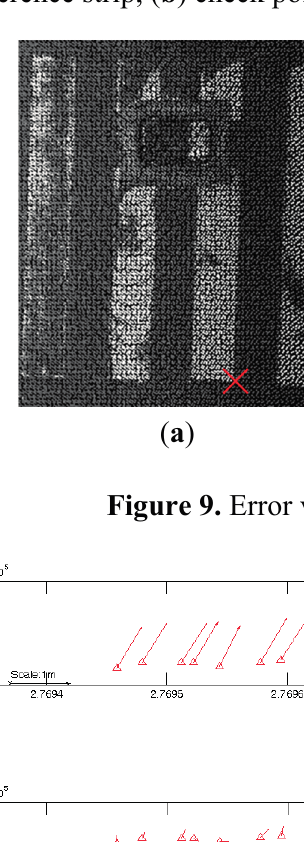
Figure 8. Illustration of independent check-point between trajectories: ( a ) check point in reference strip, ( b ) check point in registered strip.